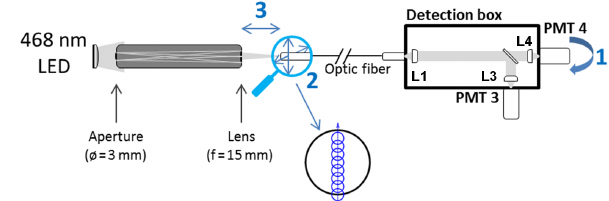
Figure 4. Schematic of the experimental setup used to test the sta- bility of the detection subsystem. The 468nm LED source, 3mm aperture, and 15mm lens simulate the incident light at the numer- ical aperture equivalent to the telescope. Three different instability sources are reproduced: (1) rotation of the PMT to test the sensi- tivity to the position of the beam on the photocathode, (2) lateral translation of the fiber input aperture with respect to the light source to simulate beam wandering at the fiber input, and (3) longitudinal translation of the fiber input to simulate the range-dependent varia- tion of the spot size at the fiber input.